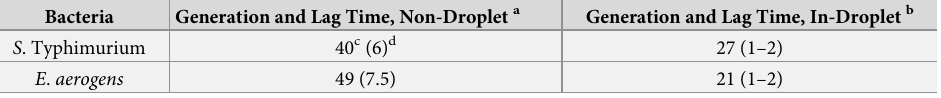
Table 3. Comparison of lag phase duration and generation times for S . Typhimurium and E . aerogens outside and inside